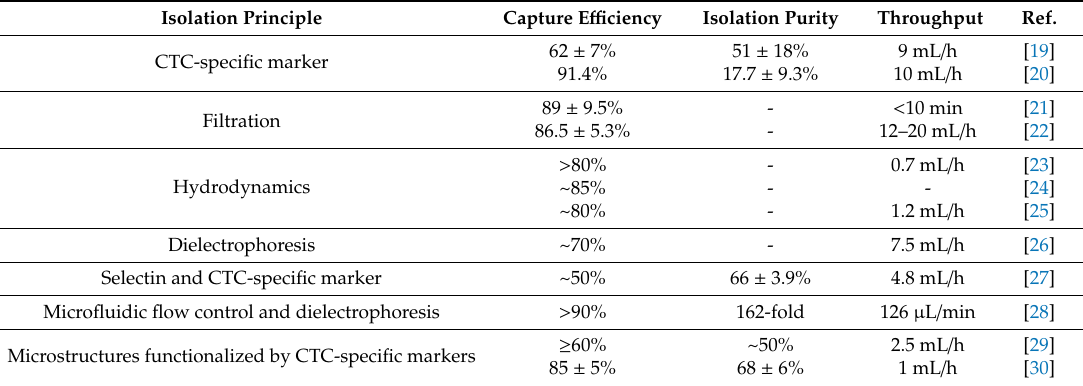
Table 2. Summary of the e ffi ciency, purity, and throughput of CTC isolation